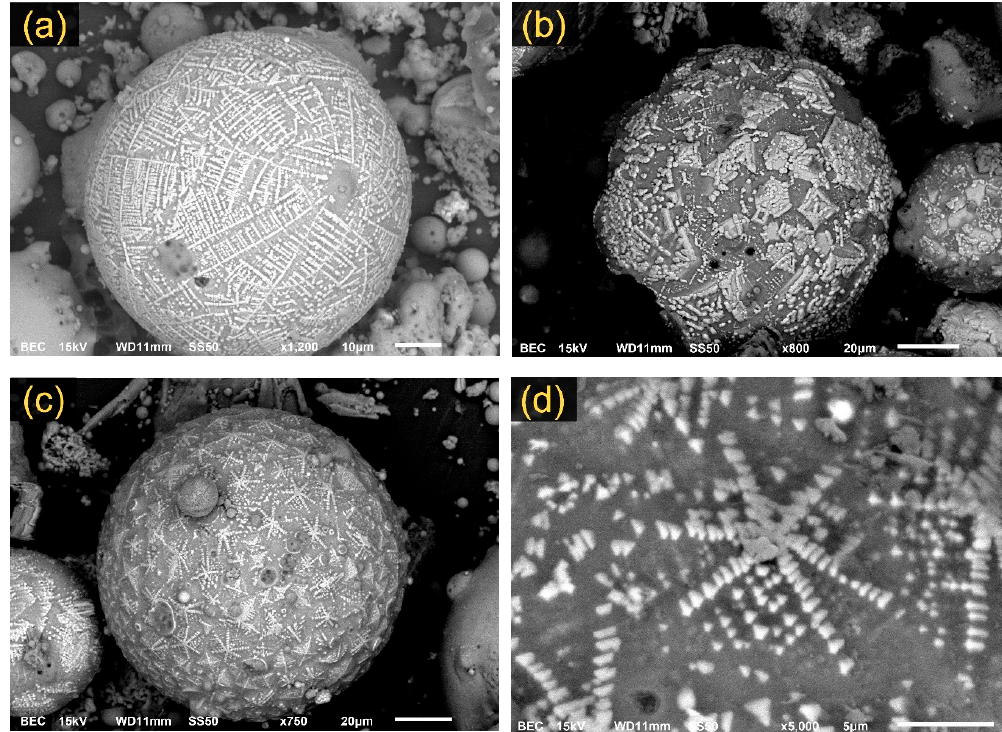
Figure 6. SEM images of the magnetite concentrate: ( a ) sphere with dendritic structures of magnetite, ( b ) sphere with hexagonal bulk agglomerates of magnetite, ( c ) sphere with star ‐ like structures of magnetite, and ( d ) individual submicron pyramidal crystals of magnetite integrated into the star ‐ like